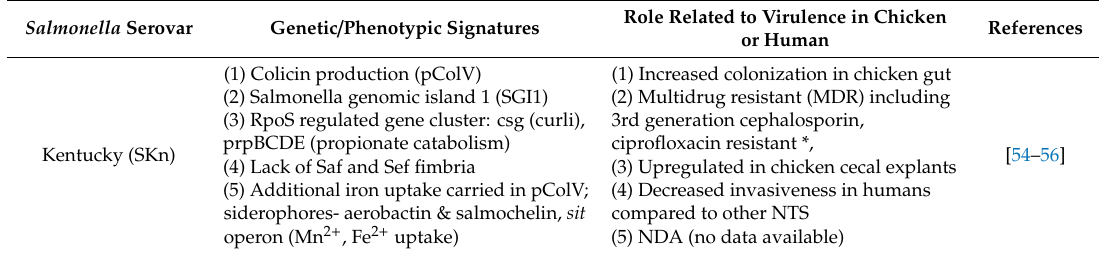
Table 2. Most prevalent chicken-associated NTS serovars with public-health